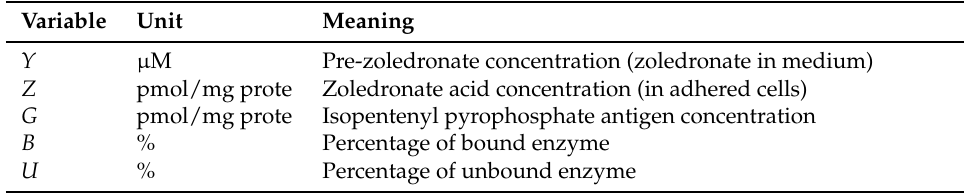
Table 1. Biological meanings of the variables used in Model 1 and Model